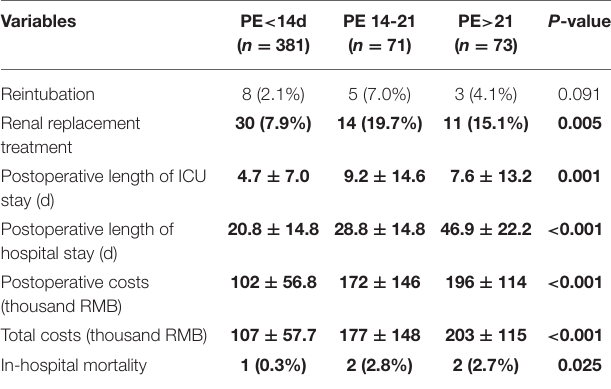
TABLE 6 | Postoperative short-term outcomes in the study